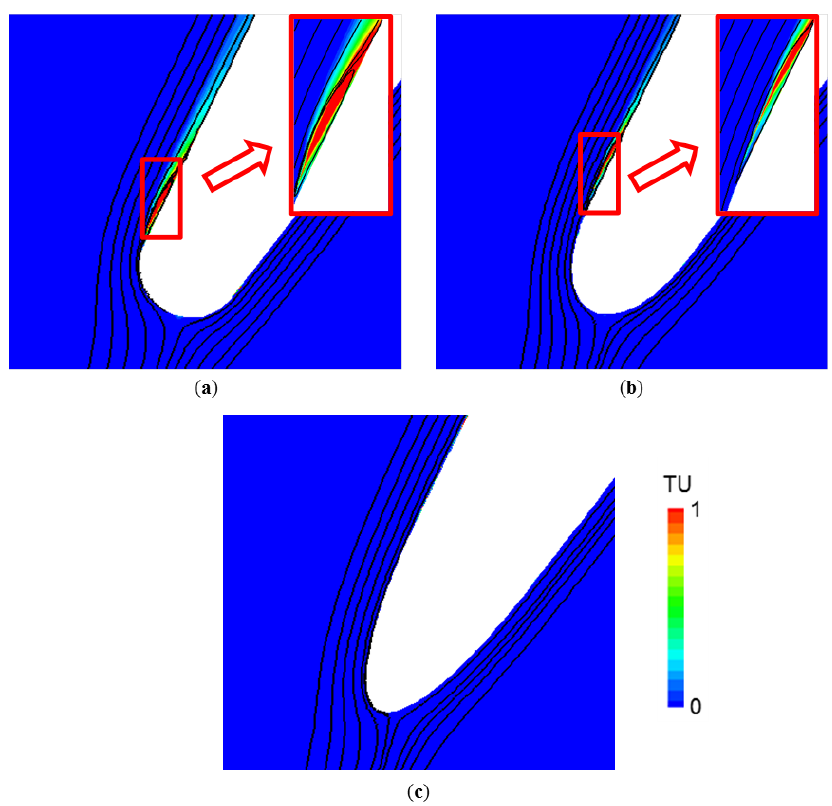
Figure 14. Streamlines and turbulence intensity distributions at α = 58°: ( a ) circular LE; ( b ) elliptical LE; ( c ) continuous-curvature